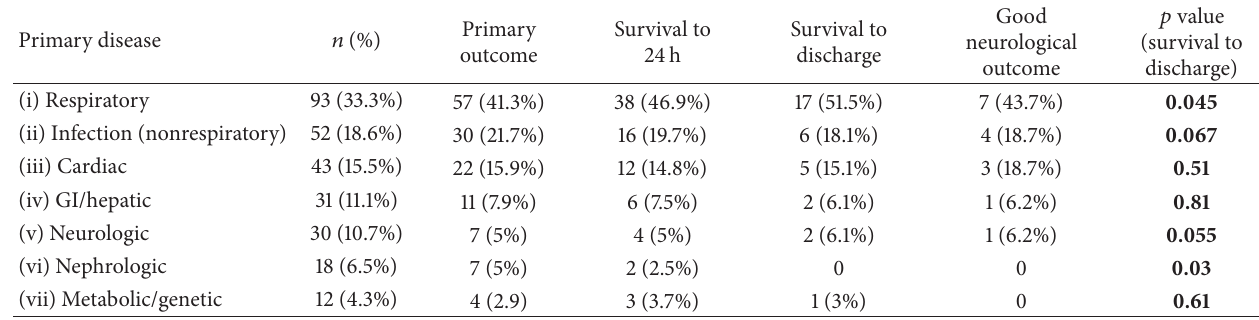
Table 3: Primary